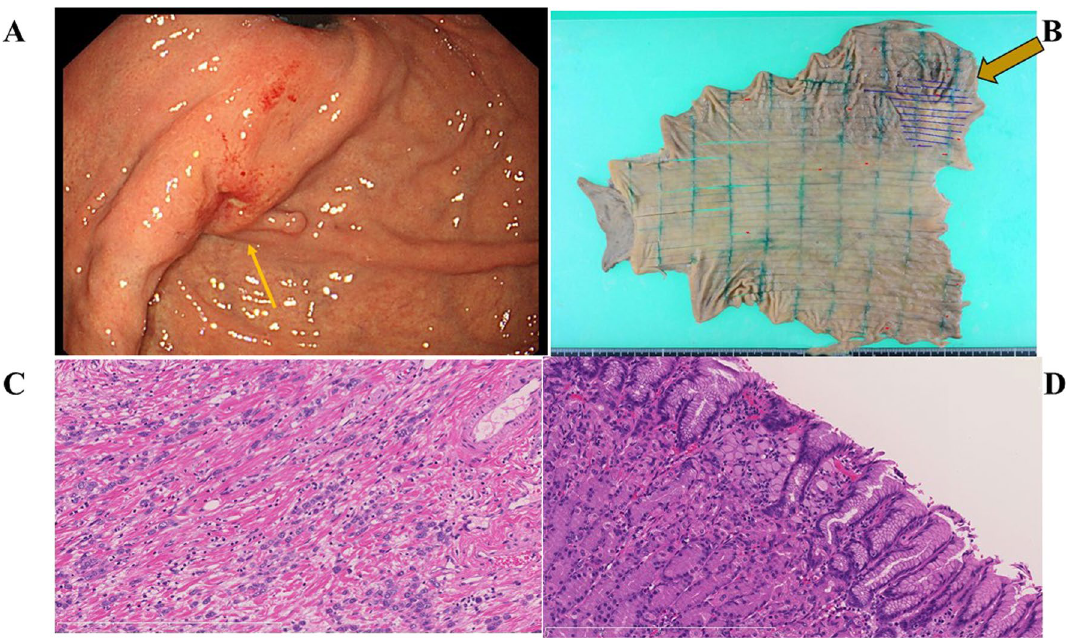
Fig. 3 Esophagogastroduodenoscopy, post-operative specimen and pathological findings in case III-6. Esophagogastroduodenoscopy showed a type 0-IIa + IIc lesion at the gastric fundus with some ulceration in the center of the lesion ( A ). Resected specimen revealed a type 3 lesion with ulceration on the anterior wall of the gastric fundus ( B , Arrow) and red dots indicated the presence of intramucosal signet-ring cells ( B ). Pathological findings revealed proliferating and infiltrating of poorly differentiated adenocarcinoma and signet ring cell carcinoma ( C , × 20) and signet ring cell carcinoma under the mucosa ( D , × 20)